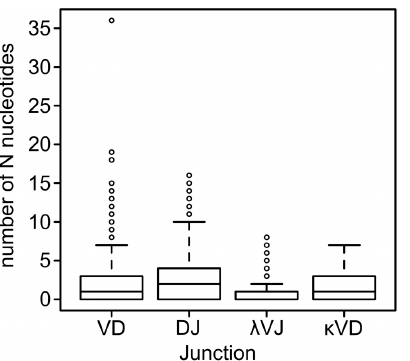
Figure 3. Junctional diversity in bovine fetuses. N nucleotide additions in IGH (VD and DJ junctions, n=645) IGL ( l VJ junction, n=65) and IGK ( k VJ junction, n=83). Dark line in the middle represents the median and 50% of the cases lie within the box. Whiskers extend to 1.5 times the height of the box. Circles represent outliers. We did not detect statistically significant differences between tissues or individuals. Heavy chain data is pooled from bone marrow, ileum and spleen (two fetuses). Light chain data is pooled from bone marrow and ileum (one fetus).